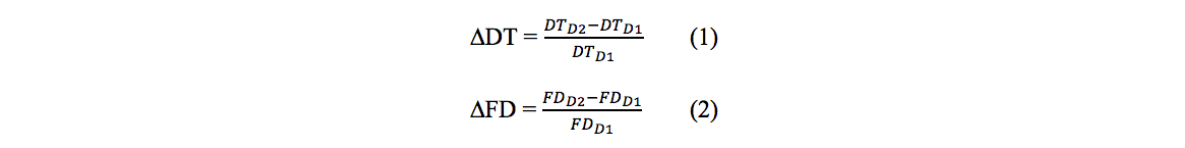
Figure 4. Equations for calculating the values of the shift in both dimensions of dwell time and fixation duration ( ∆ DT and ∆ FD) from UI design D1 to